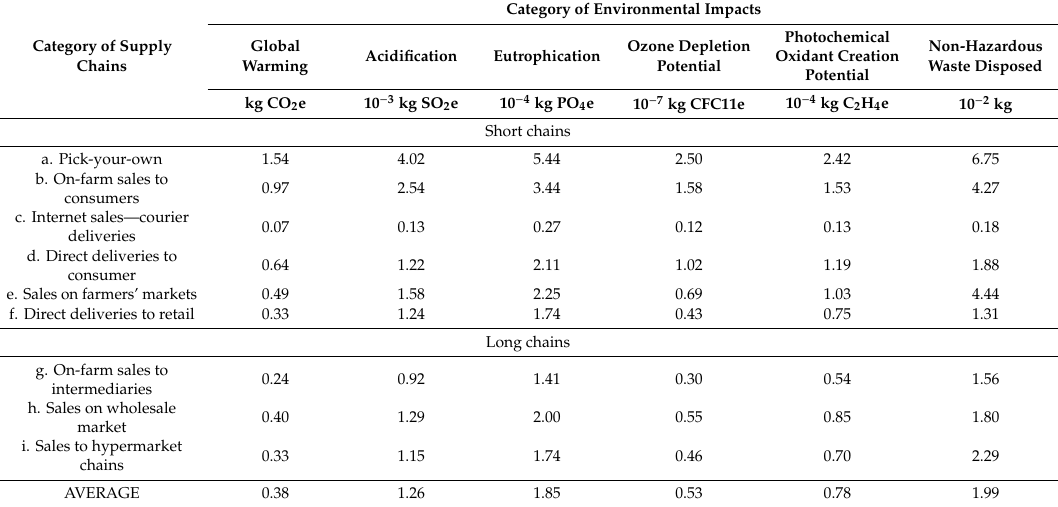
Table 11. Eco-e ffi ciency LCA indicators assessed for short and long food supply chains (kg emissions / kg of product).